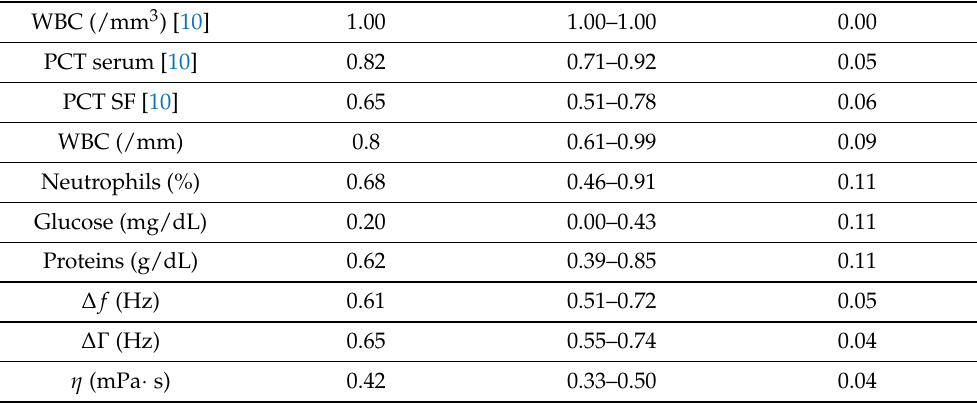
Table 6. Area under the ROC curve values for the parameters as predictors for infectious fluid (SF in tubes with lithium